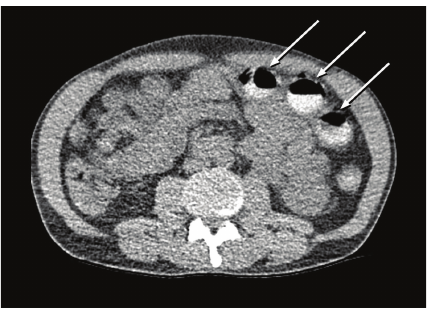
Figure 1: CT scan showing three of four, round, foreign bodies (arrows) in the left transverse colon.